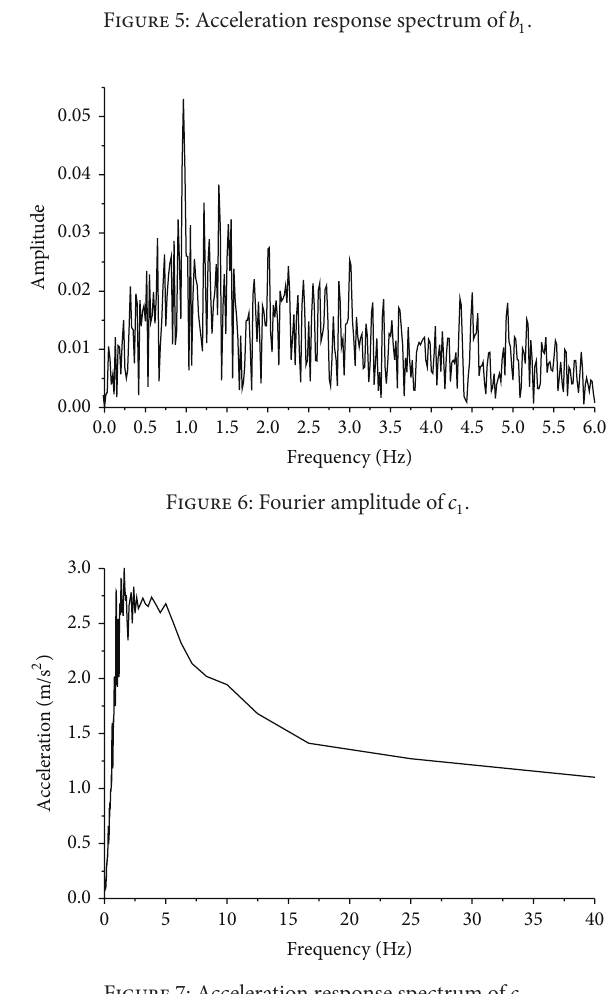
Figure 7: Acceleration response spectrum of 𝑐 1